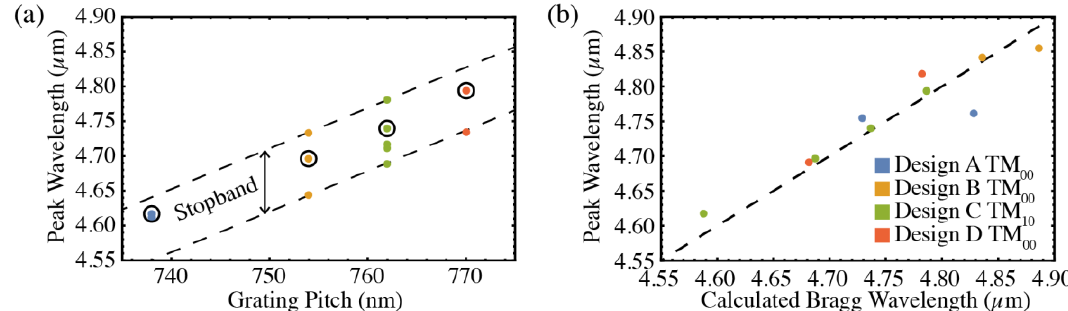
Figure 7. ( a ) Measured peak wavelengths as a function of DFB grating pitch for all four lasers of